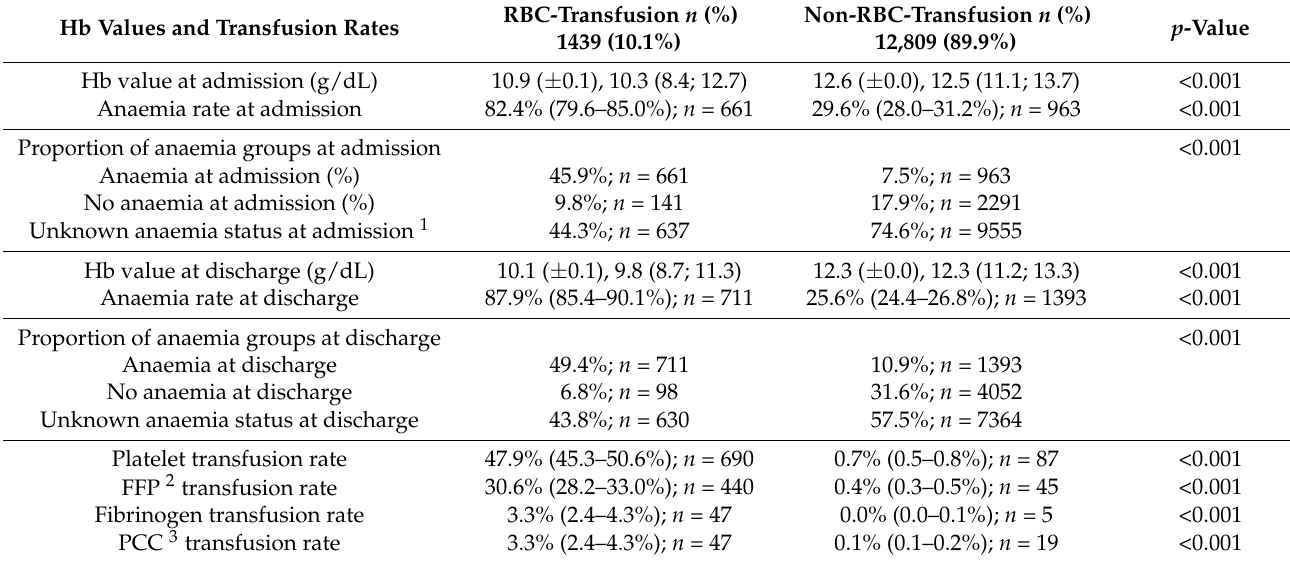
Table 3. Haemoglobin values and transfusion rate.